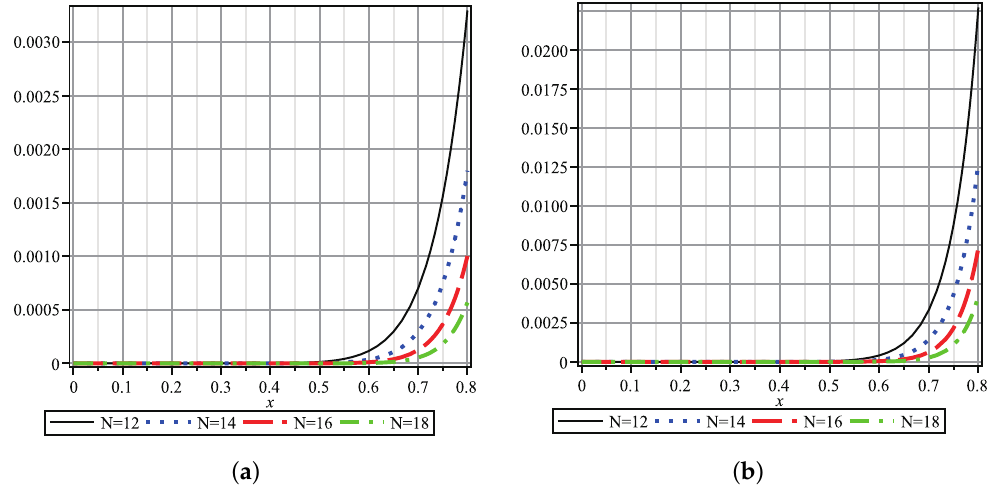
Figure 1. The curves of absolute errors of the approximate solutions in problem (47): ( a ) For the approximate solution u N ( x ) . ( b ) For the approximate solution v N ( x )